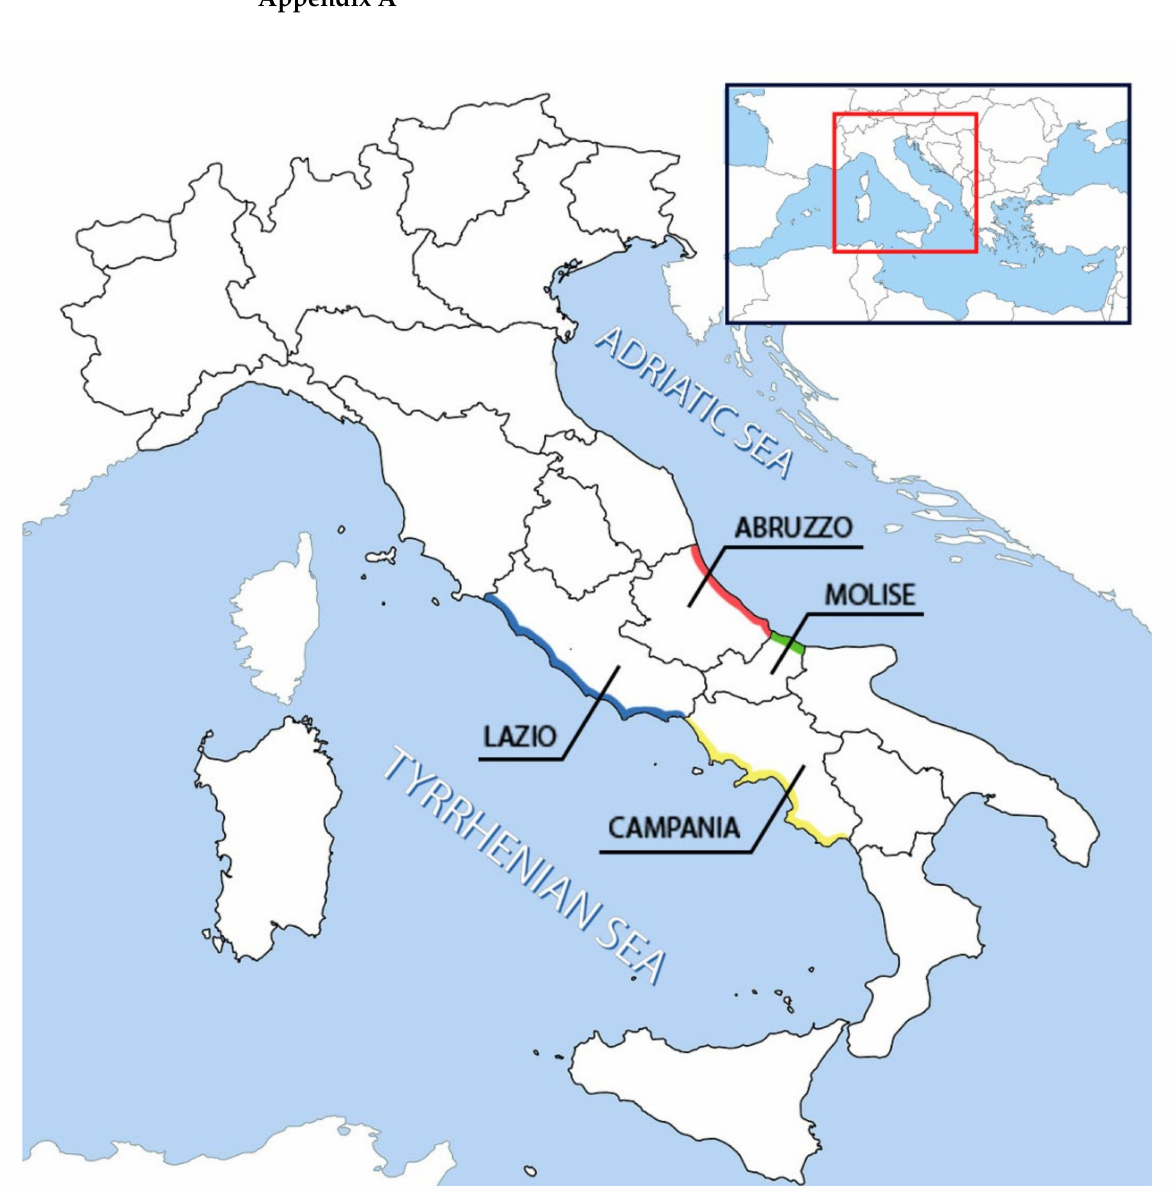
Figure A1. Map of the study area: the regions are shown, and the coastline is highlighted in